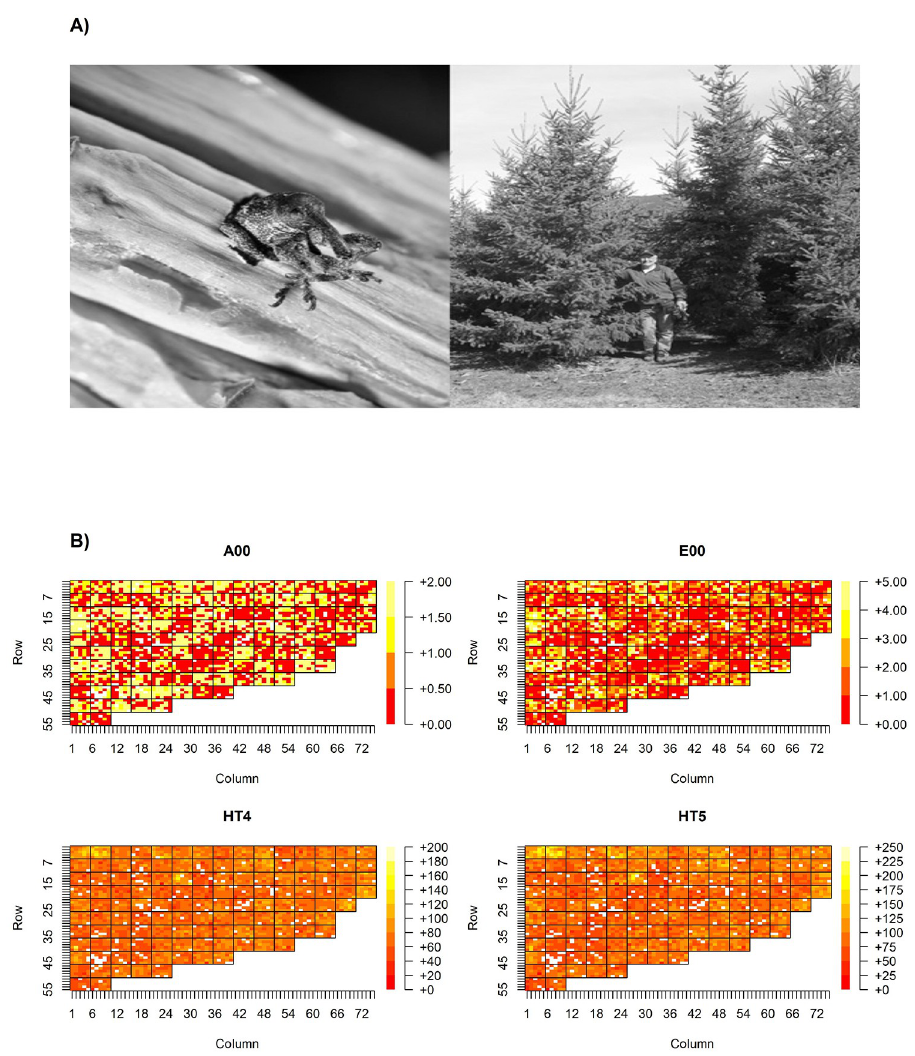
Fig 1. Spruce shoot weevil trial in the interior of British Columbia, Canada. A) Photo to the left: emerging Pissodes strobi individual during the weevil rearing experiment (photo credit: Ward Strong); photo to the right: Kalamalka Research Station based Interior spruce weevil trial after thinning (photo credit: Val Ashley). B) Spatial distribution for classes of attack severity (upper left plot, A00), egg punctures occurrence (upper right plot, E00) in the year 2000, as well as for heights measured in cm at four years (bottom left plot, HT4 in the year 1998) and five years of age (bottom right plot, HT5 in the year 1999), respectively, on an individual tree basis within the experimental plot. Family plots are distinguished in the grid, where individual trees are indexed by row and column numbers. The plot outline of the entire trial on a family basis is provided in [33]. Forty-two controlled crosses were generated by mating resistant with resistant, resistant with susceptible, and susceptible with susceptible parents. The ranking in terms of weevil resistance of the individual Interior spruce parents is known and was done previously [13]. The evaluation of attacks was done following artificial weevil infestation of the spruce resistance trial. Height data from pre-attack years are shown. The colour code for ascending phenotypic values (that is for classes of attack severity, egg punctures occurrence, heights) is provided to the right of each plot outline. No formal statistical analysis on the spatial distribution of the weevil attack severity was attempted for this experiment designed as family-based plots where each plot contained 25 individuals of the same